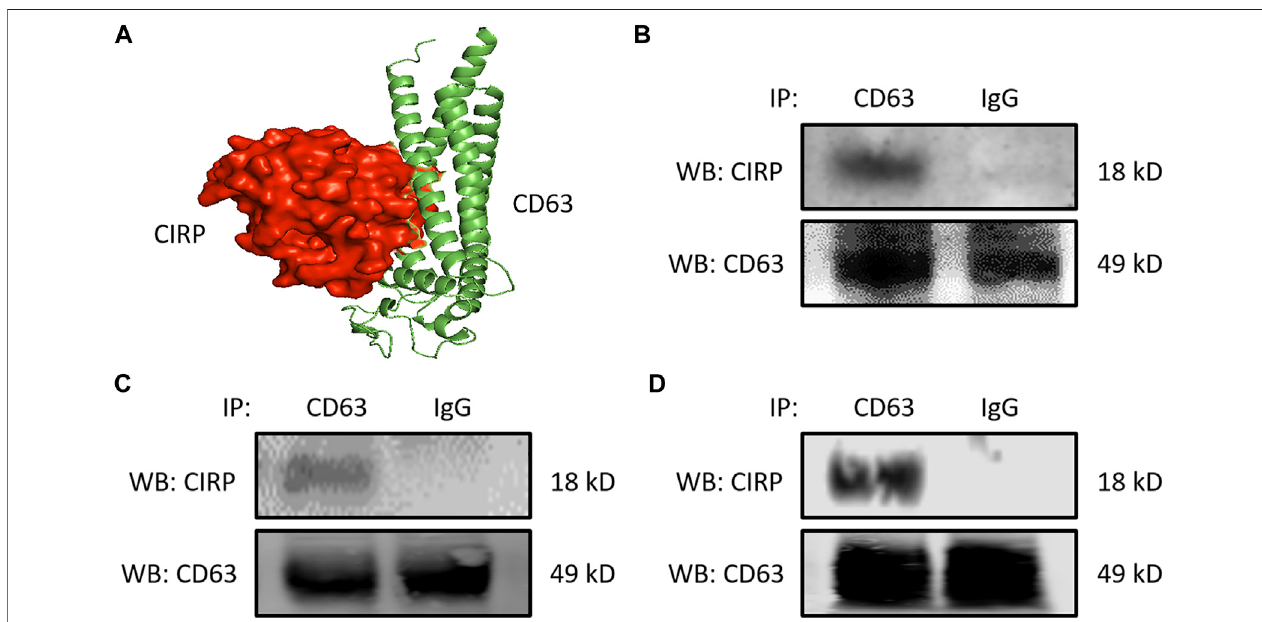
FIGURE 2 | CIRP interacts with CD63, a member of the tetraspanin family intracellularly. (A) Molecular binding between CIRP and CD63 was predicted by 3D computational modeling. (B) RAW 264.7 cells challenged with LPS for 20 h and peritoneal cells isolated from mice (C) 4 h after LPS injection or (D) 20 h after CLP were lysed and immunoprecipitated with anti-CD63 Ab or IgG control. Precipitated proteins were subjected to WB of anti-CIRP Ab. CD63 levels of the total lysates were assessed by WB for the internal control. The experiment was repeated three times.